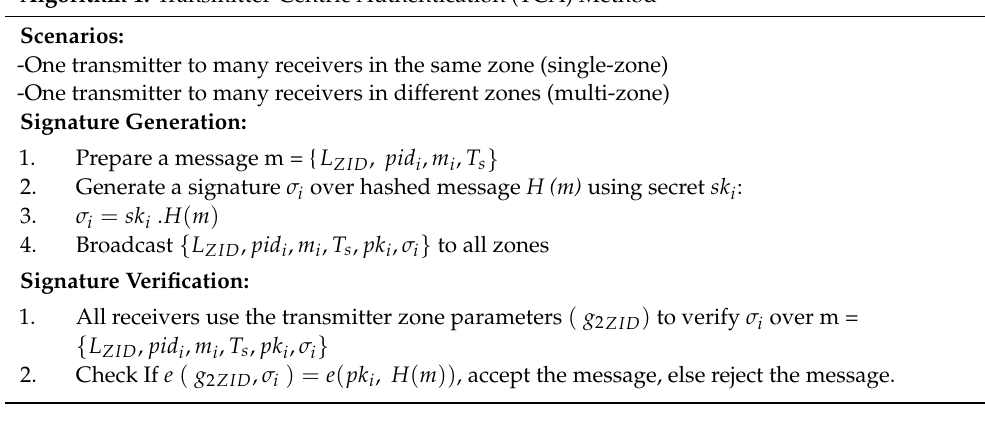
Algorithm 1: Transmitter-Centric Authentication (TCA)